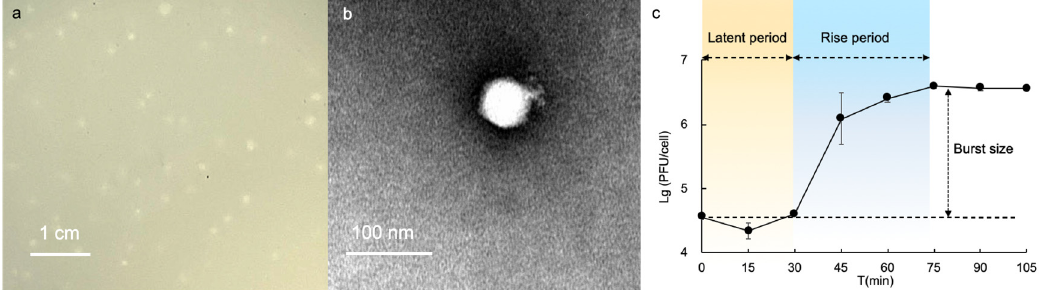
Figure 1. Biological characteristics of the alterophage vB_AmeP-R8W (R8W). ( a ) Image of plaques 24 h after infection. ( b ) TEM of the podovirus alterophage R8W. ( c ) One-step growth curve of R8W in the host, Alteromonas mediterranea strain DE. Error bars indicate standard deviation.